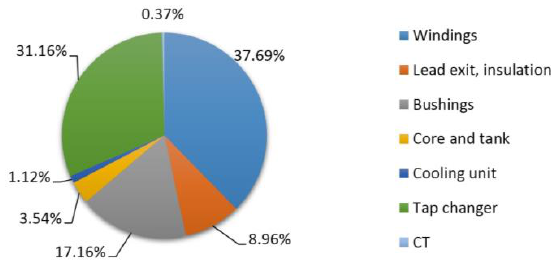
Figure 1. Failure locations of substation transformers (>100 kV) (based on 536 major failures) [4].